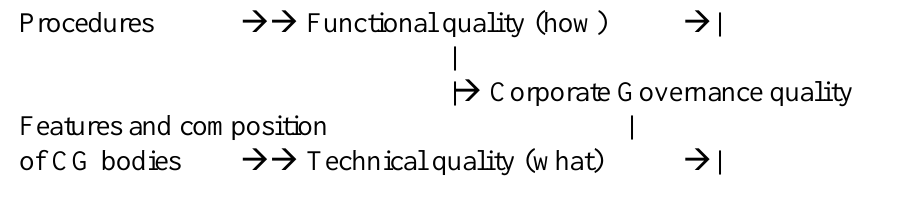
Figure 3.1 The CG Index Dimension Procedures  Functional quality (how)  | | |  Corporate Governance quality Features and composition | of CG bodies  Technical quality (what)  | Source: Grönroos (1990), with